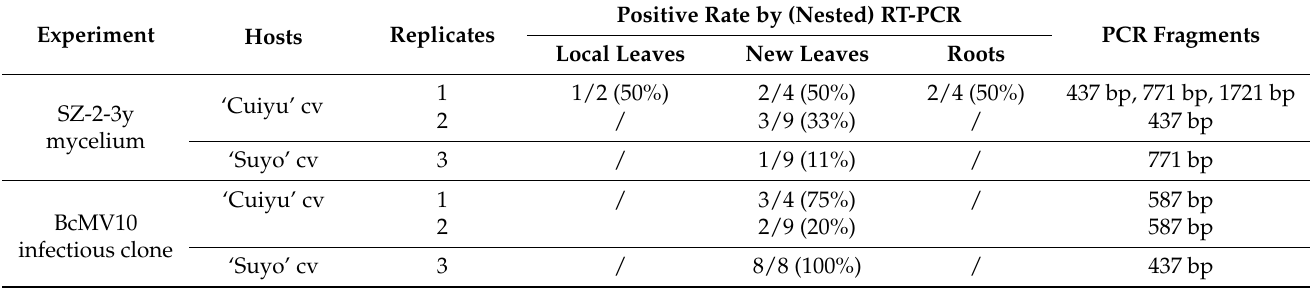
Table 3. BcMV10 sequences were detected in cucumber plants following inoculation of cucumber cotyledons with SZ-2-3y mycelia and agro-infiltration with the pXT1/BcMV10